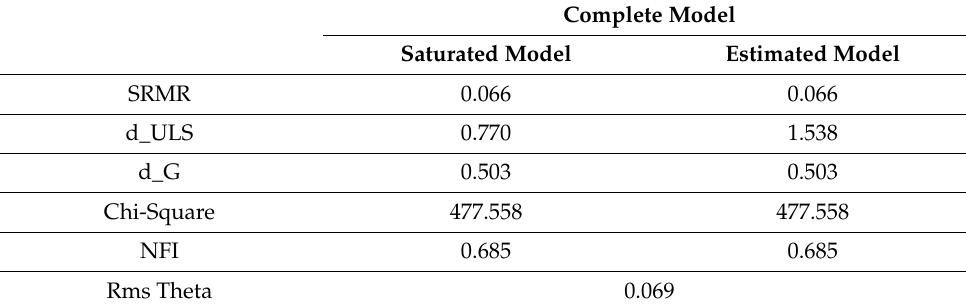
Table 8. Model fit indicators.